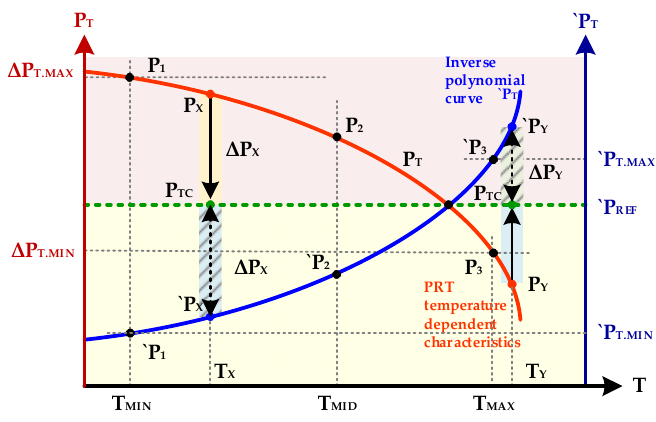
Figure 3. Concept of pressure and its compensation polynomials.